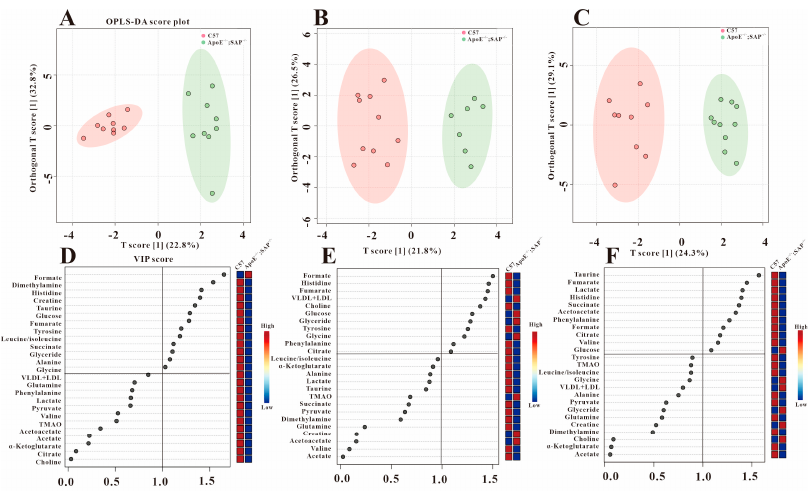
Figure 5. Metabolic differences between C57 and ApoE − / − ;SAP − / − groups at three periods. OPLS − DA scores plots ( A ) (8 w), ( B ) (8 + 4 w), ( C ) (8 + 8 w) and VIP scores ( D ) (8 w), ( E ) (8 + 4 w), ( F ) (8 + 8 w).